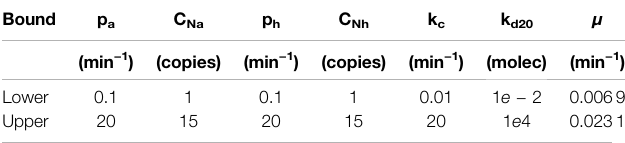
TABLE 2 | Lower and upper bounds for the naringenin pathway MOP.